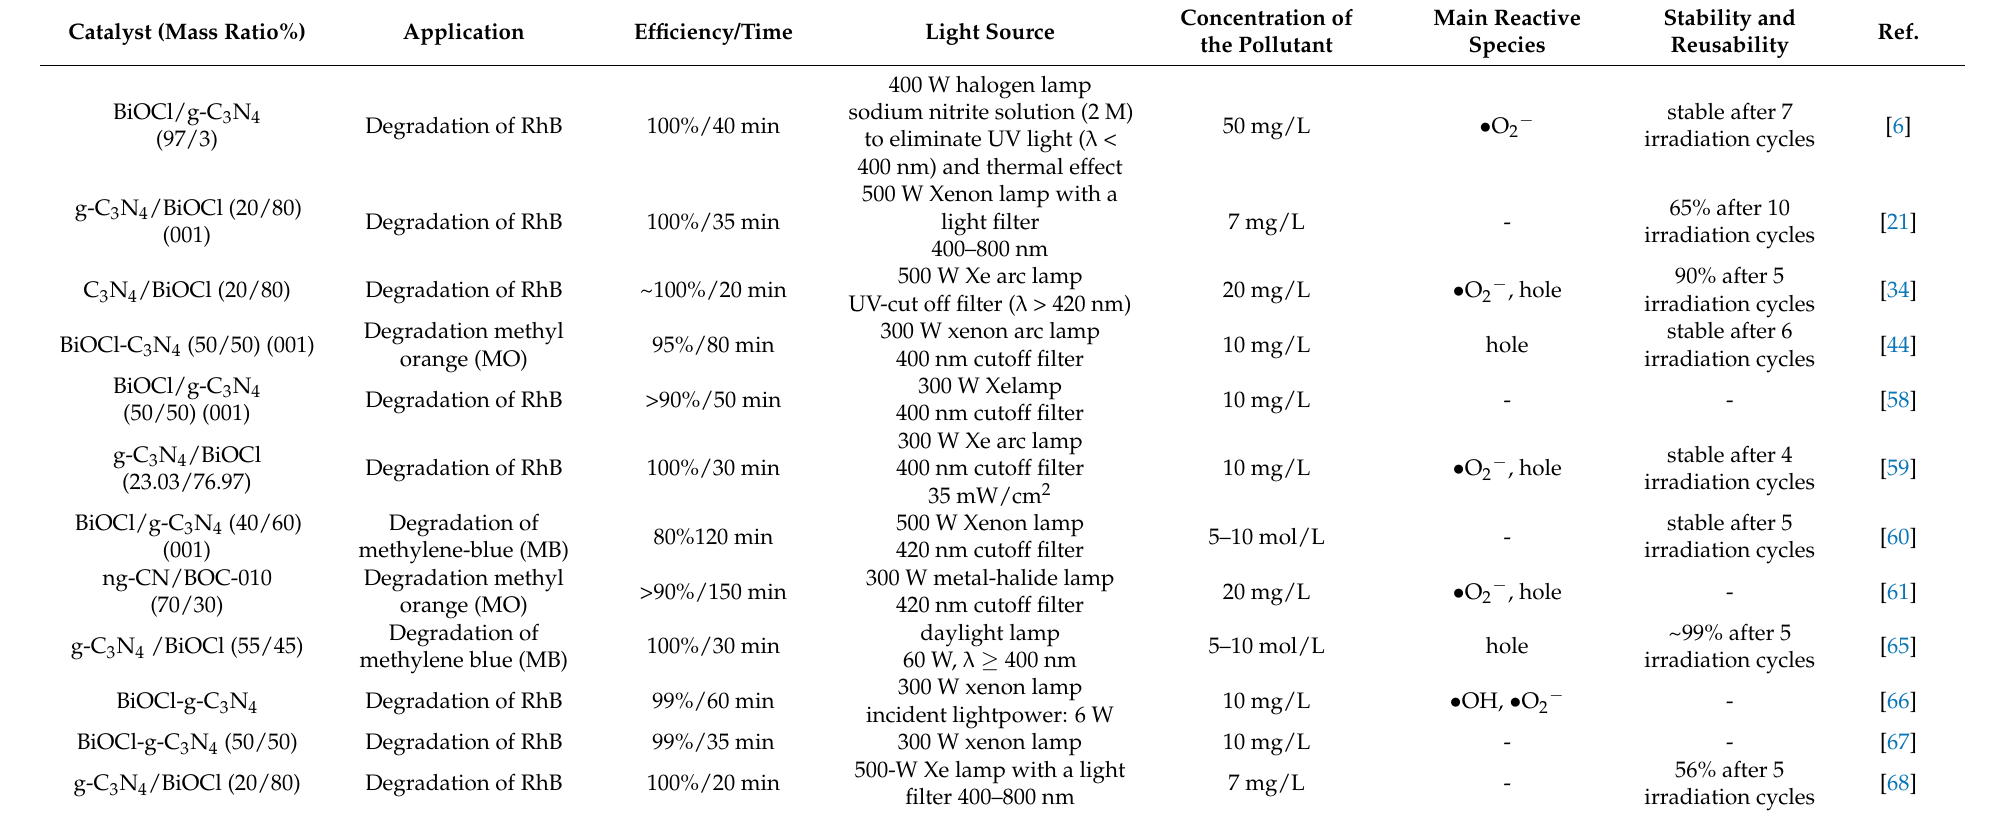
Table 4. G-C 3 N 4 /BiOCl heterojunctions applied to dye